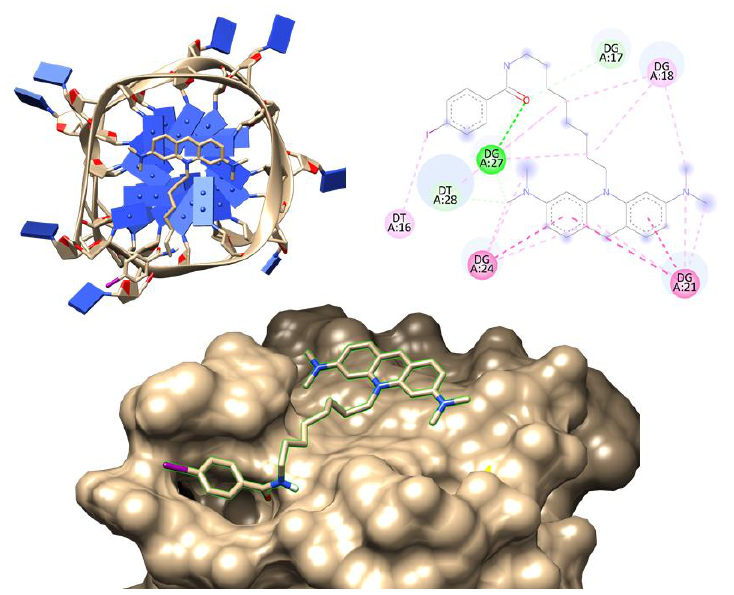
Figure 3. Molecular docking simulation of AT11 aptamer with C 8 . The image depicts the lowest binding free energy complex and the interactions with nucleotide residues.